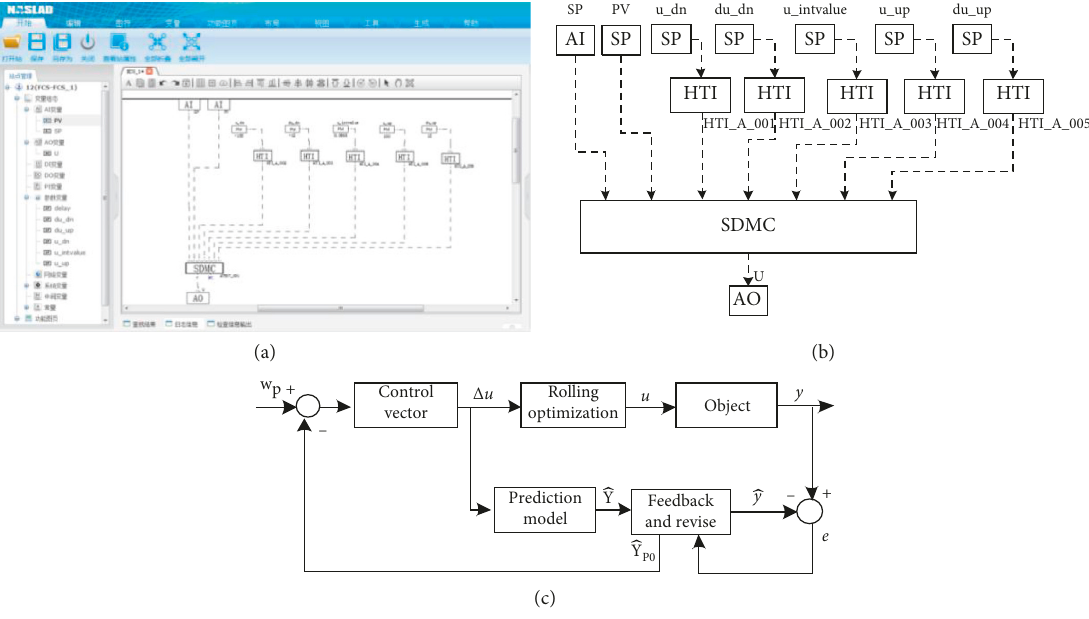
Figure 5: SDMC Logic in NASLAD. (a) NASLAD software. (b) Framework of SDMC. (c) Control principle block diagram of SDMC.